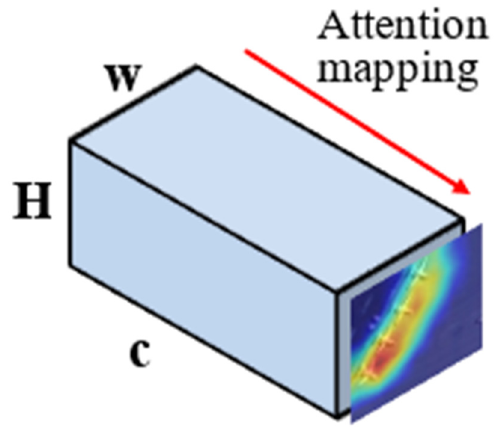
Figure 4. Attention mapping over conv_5 feature maps from fine-tuned resnet-18 model.3.3. Feature Fusion.